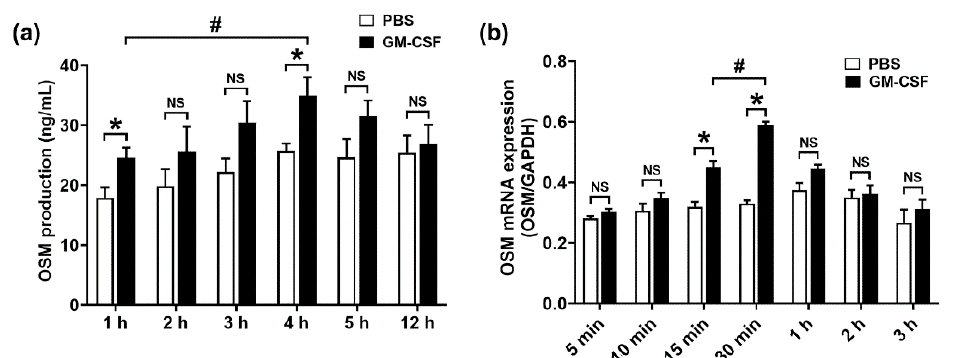
Figure 1. Production and mRNA expression of OSM in neutrophil-like dHL-60 cells. ( a ) dHL-60 cells (5 × 10 5 ) were stimulated with GM-CSF (5 ng/mL). OSM levels were measured with the ELISA method. ( b ) dHL-60 cells (1 × 10 6 ) were stimulated with GM-CSF (5 ng/mL). OSM mRNA levels were measured with the real-time PCR method. PBS—PBS-treated and unstimulated cells; GM- CSF—PBS-treated and GM-CSF-stimulated cells. Data are presented as the mean ± S.E.M. of three independent experiments. * p < 0.05 vs. the PBS-treated and unstimulated cells. # p < 0.05 vs. the indicated group. NS, not significant.